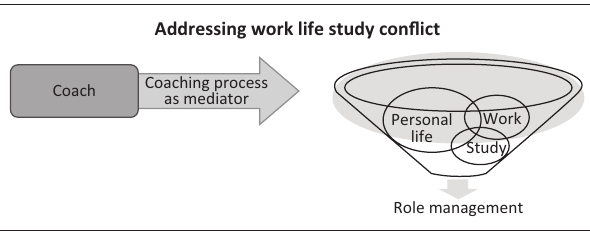
FIGURE 1: Framework for personal life as a mediator for study and work